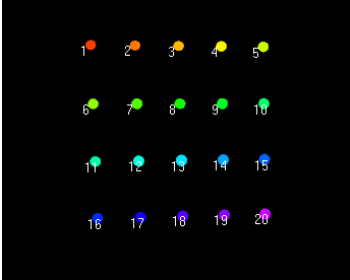
Figure 2: A visualization of the markers seen and identified by the Qualisys Oqus 3+